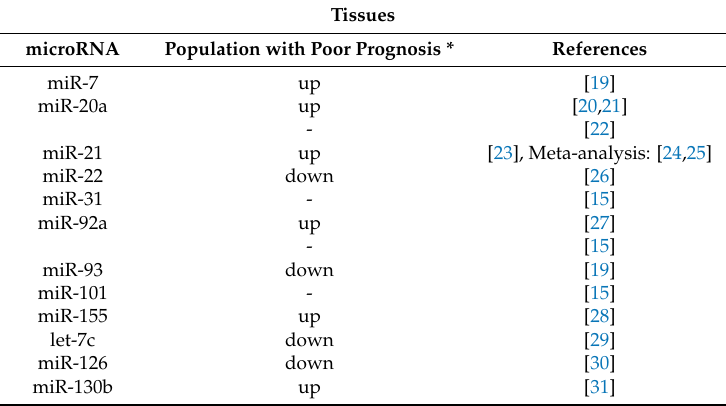
Table 1. Tissue and blood microRNAs as prognostic biomarkers for